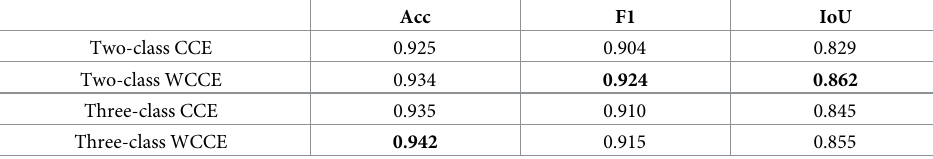
Table 4. Evaluation of U-Net segmentation models trained with different cost functions (CCE and WCCE).